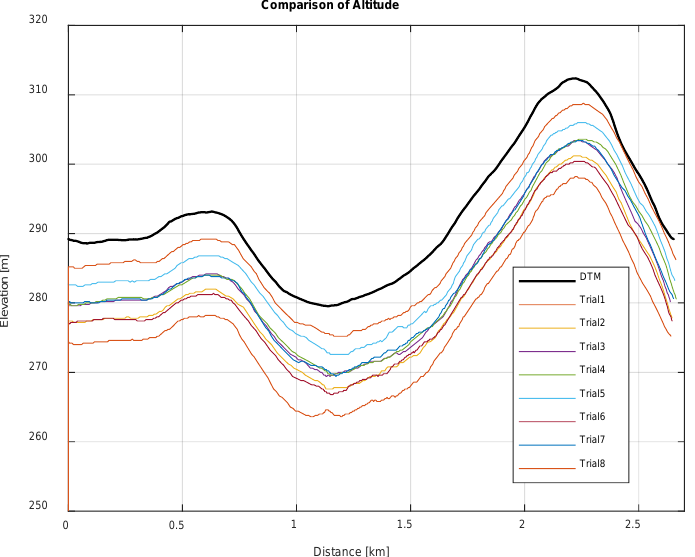
Figure 15. Comparison of registered altitudes and altitude determined from the DTM.